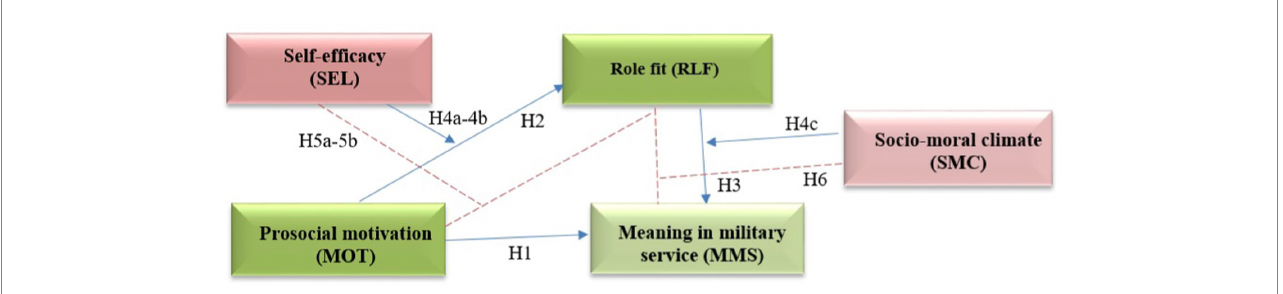
FIGURE 2 Hypothesized theoretical moderated-mediation model (at the end of military training): H1 and H2 represent main effect of prosocial motivation (MOT2), H3—the mediation of Role fit (RLF), H4a, H4b, and H4c—the moderation effects, and H5—the indirect effect of prosocial motivation (MOT2) on meaning in military service (MMS) through Role fit